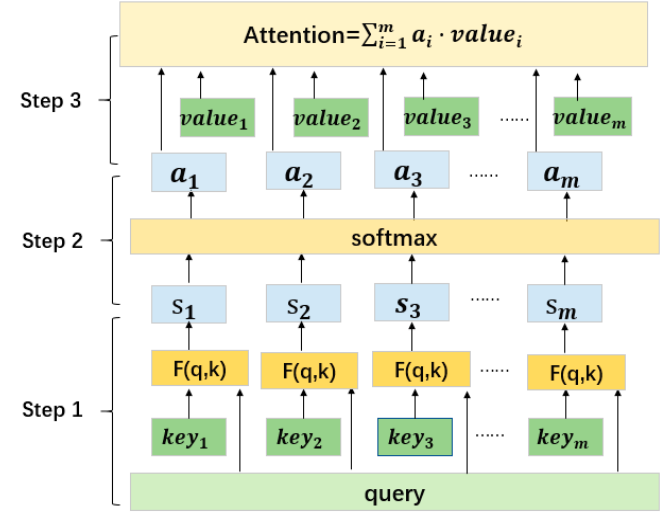
Figure 2. The flowchart of attention mechanism.